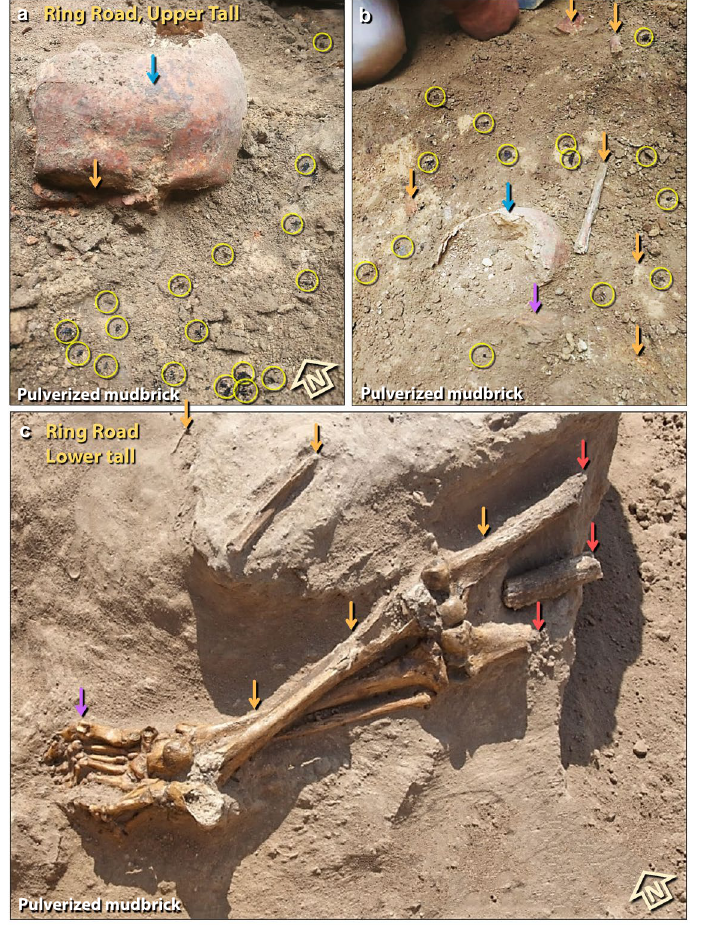
Figure 44. Human bones in the destruction layer. ( a ) Photo of a disarticulated skull found near the palace on the ring road around the upper tall. The right eye socket has been crushed (orange arrow). Skull is embedded in pulverized mudbrick containing numerous charcoal fragments (yellow circles) and is stained with ash commonly found in the destruction layer (blue arrow). The orange tint of the skull suggests it was exposed to temperatures > 200 °C 141 . ( b ) Rear view of the same skull in panel ‘ a ’ (blue arrow) near the second skull (purple arrow) and numerous disarticulated, fragmented human bones (orange arrows). Charcoal fragments at yellow circles. ( c ) Lower torso from the ring road of lower tall (orange arrows), and other disarticulated bones. Bones show evidence of being burned (red arrows); the rest of the skeleton is dismembered and disarticulated. Hyper- flexed toes (purple arrow) are consistent with either perimortem or postmortem exposure to high